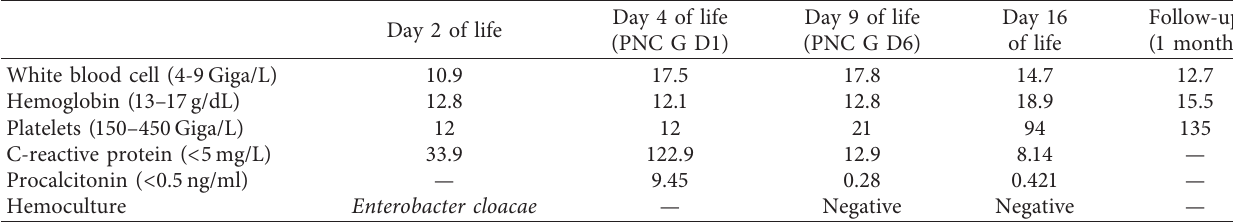
Table 1: Laboratory investigations during hospitalization.